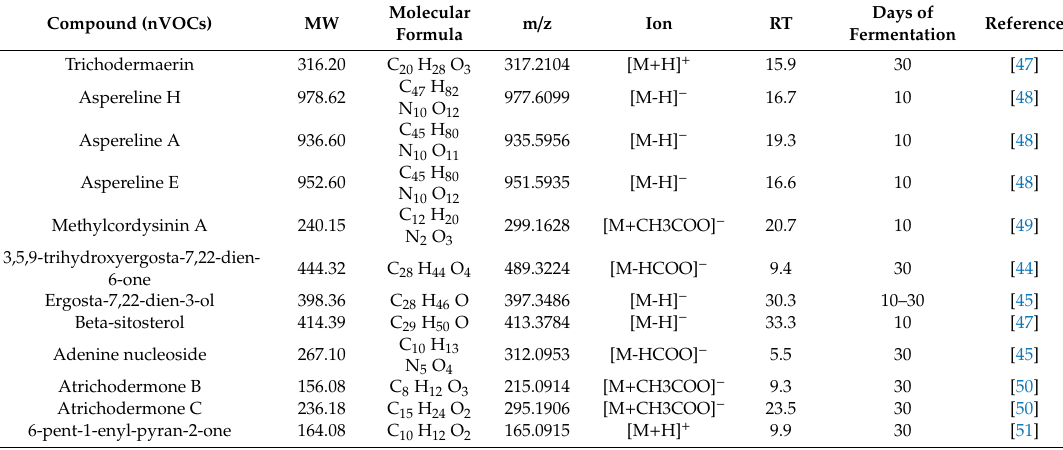
Table 5. Nonvolatile compounds (nVOCs) in the EtOAc extracts after 10 and 30 days of incubation identified by